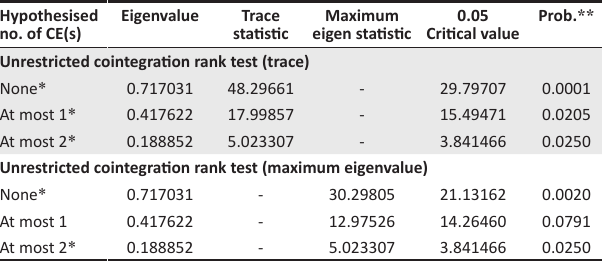
TABLE 4: Results of the cointegration test.